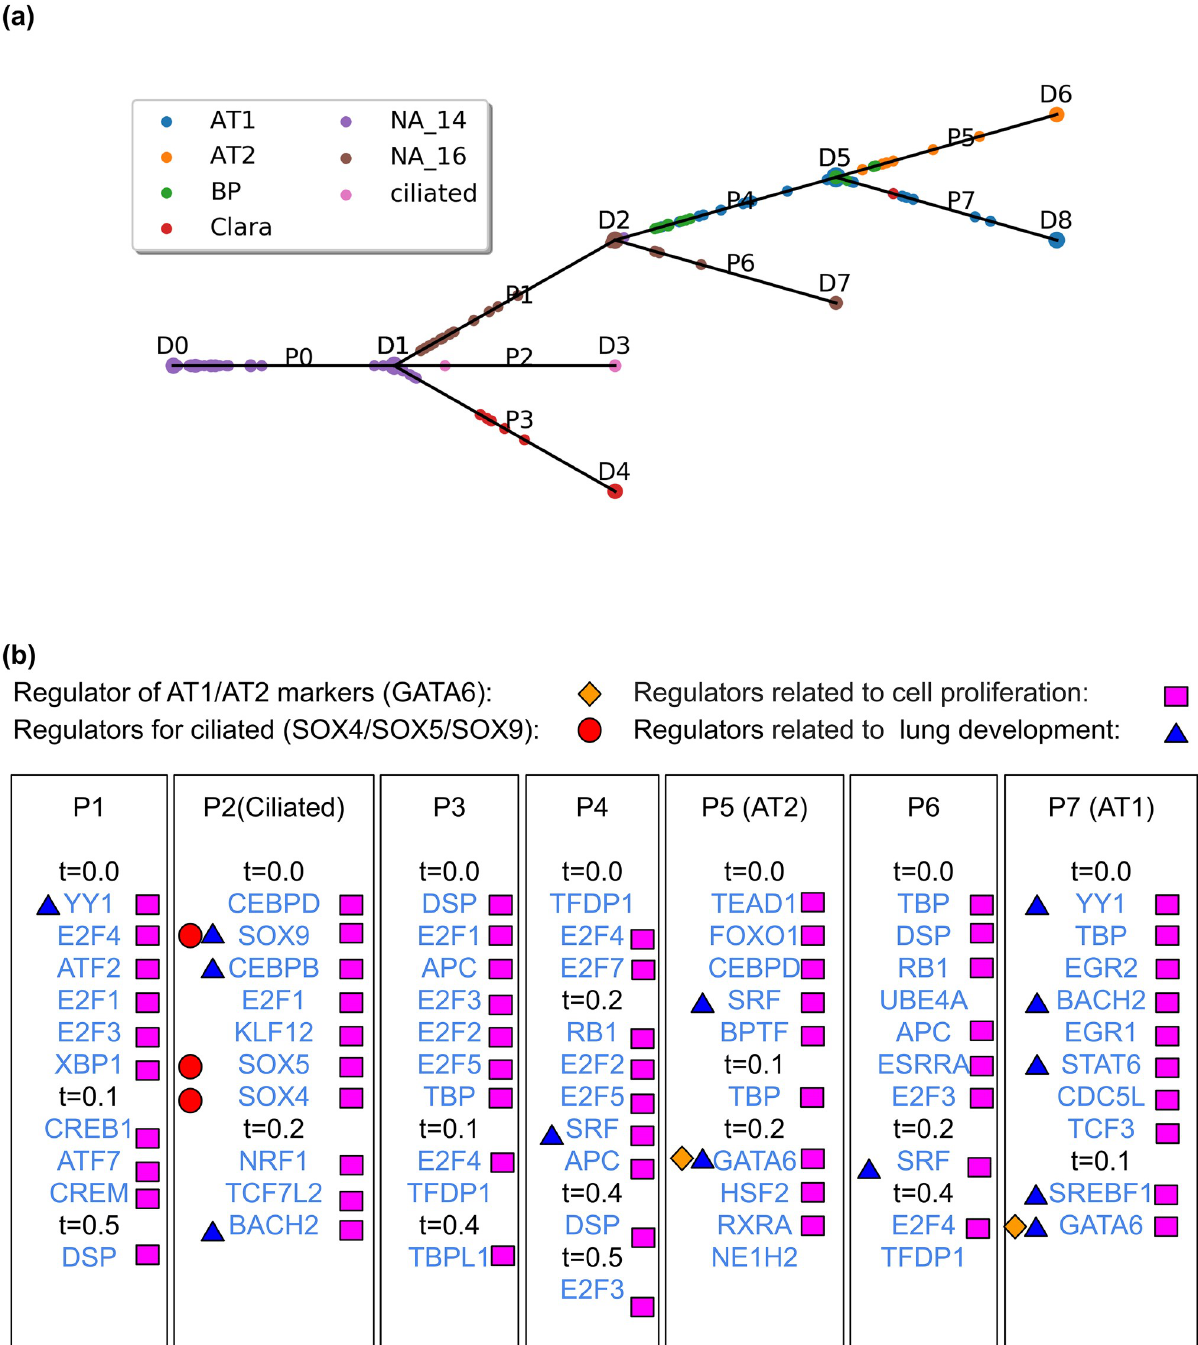
Fig 3. CSHMM-TF result for the lung development dataset. (a) CSHMM-TF structure and continuous cell assignment for lung development dataset. Notations are similar to the ones described in Fig 2 (b) TF assignments to each path by CSHMM-TF. We highlight known functional roles for several TFs. Path names (Ciliated, AT1 etc.) are based on annotated cells assigned to that path in the figure above.